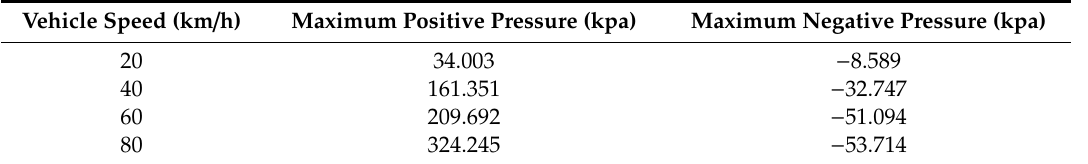
Table 3. The peak pore water pressure at di ff erent speed.